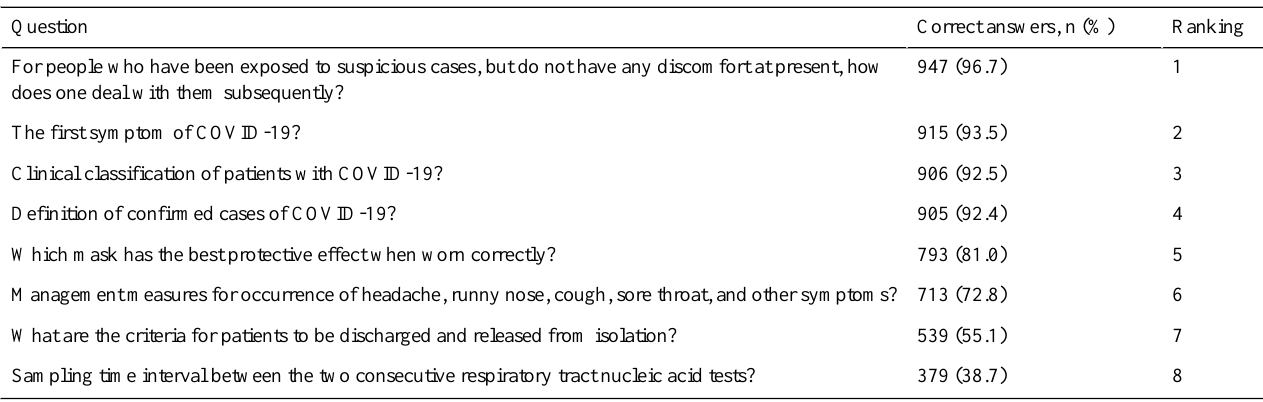
RankingCorrect answers, n